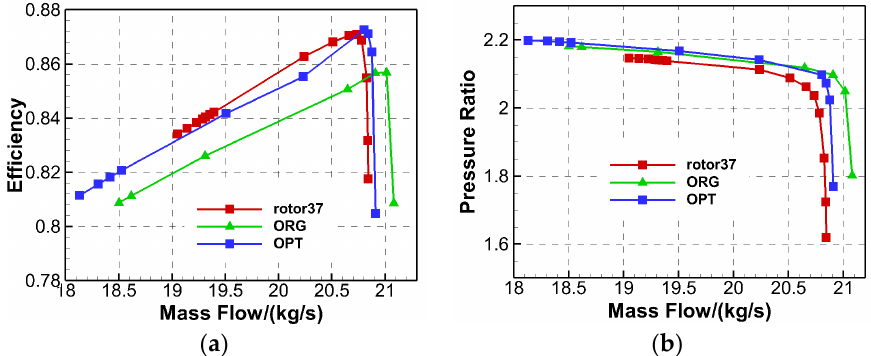
Figure 9. The characteristics comparison of Rotor37 and the original and optimized tandem rotor. ( a ) The isentropic efficiency; ( b ) the total pressure ratio.